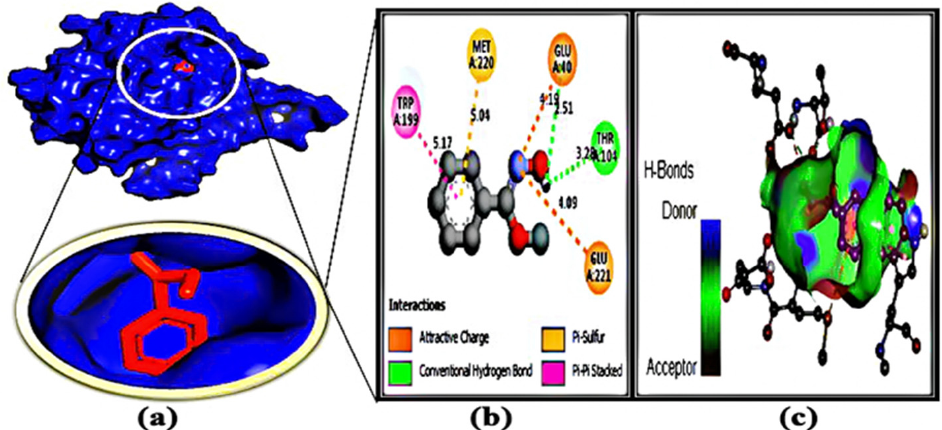
Figure 5. Docking simulation between protein–ligand interactions of nucleosidase (MTAN) enzymes and oxime-, methoxy-phenyl-, respectively, with ( a ) cartoon view (binding pocket), ( b ) 2D view, and ( c ) hydrogen bonding.